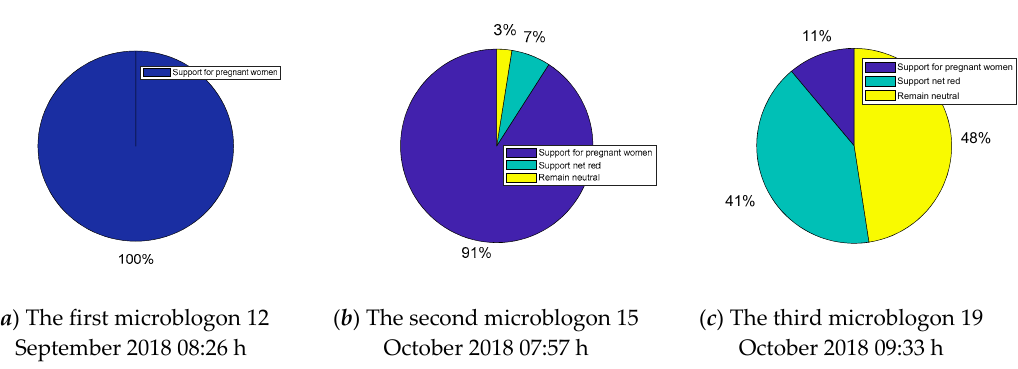
Figure 25. Opinion distributions of the event “web celebrity beating a pregnant woman”.